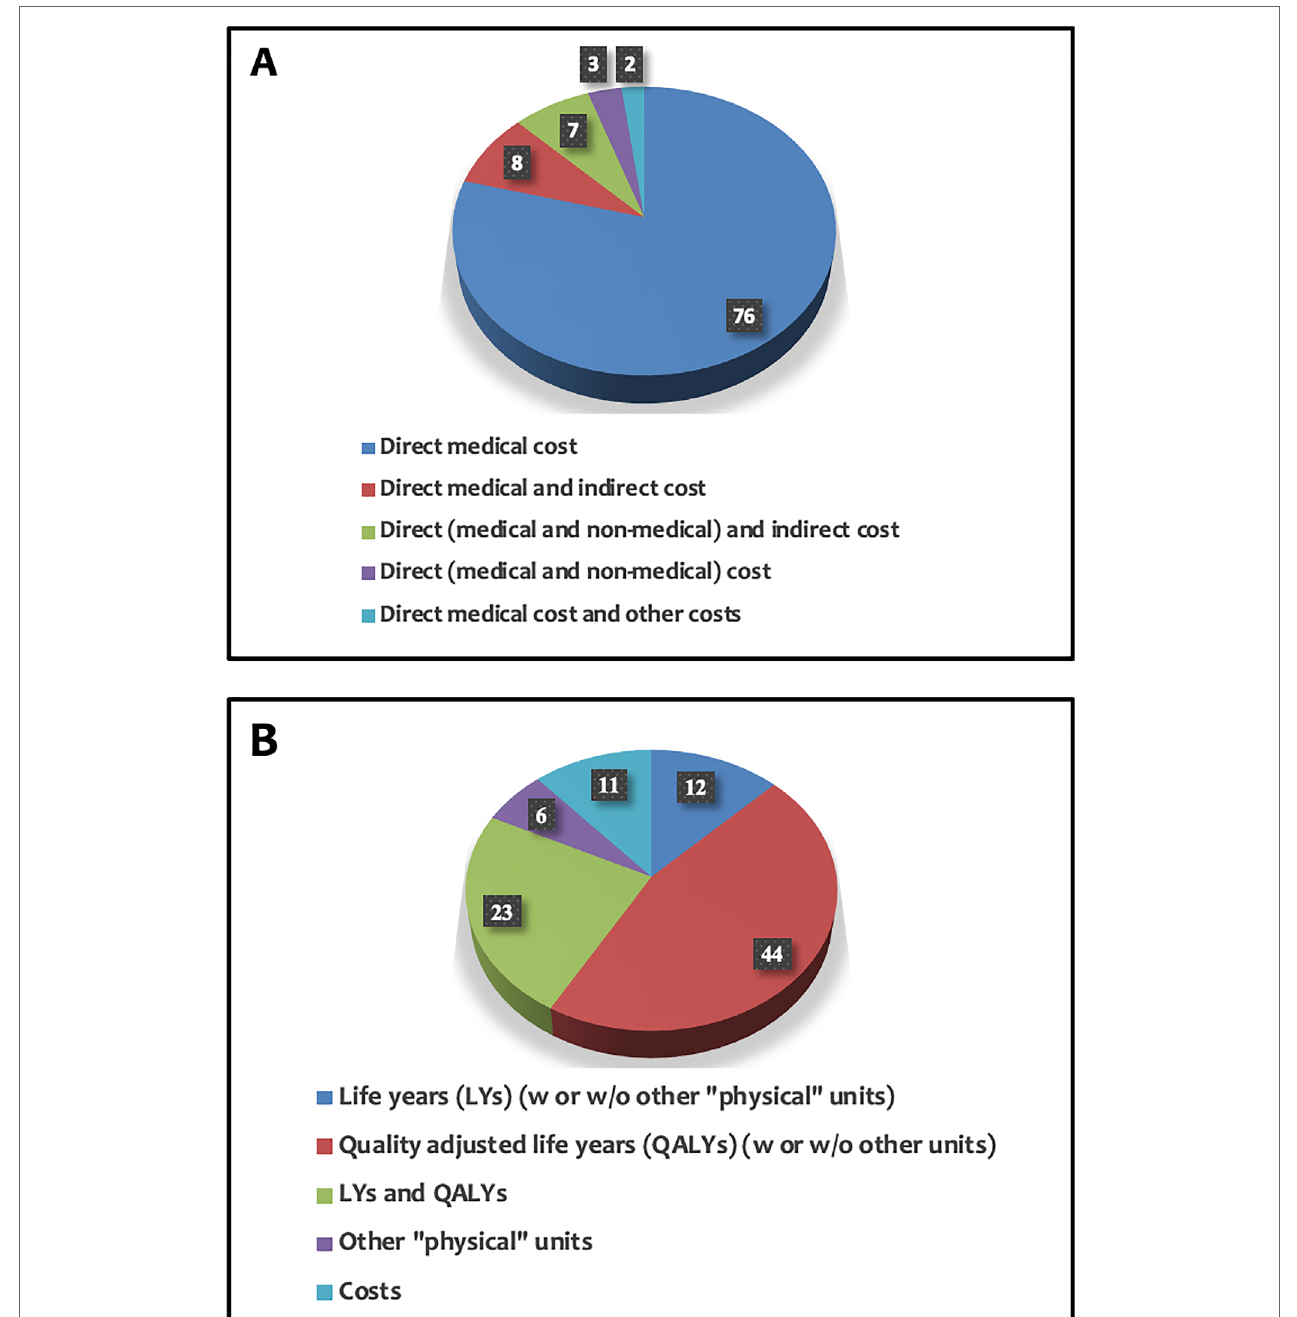
FIGURE 3 | Measurement of cost (A) and outcome (B) in the articles analyzed within this